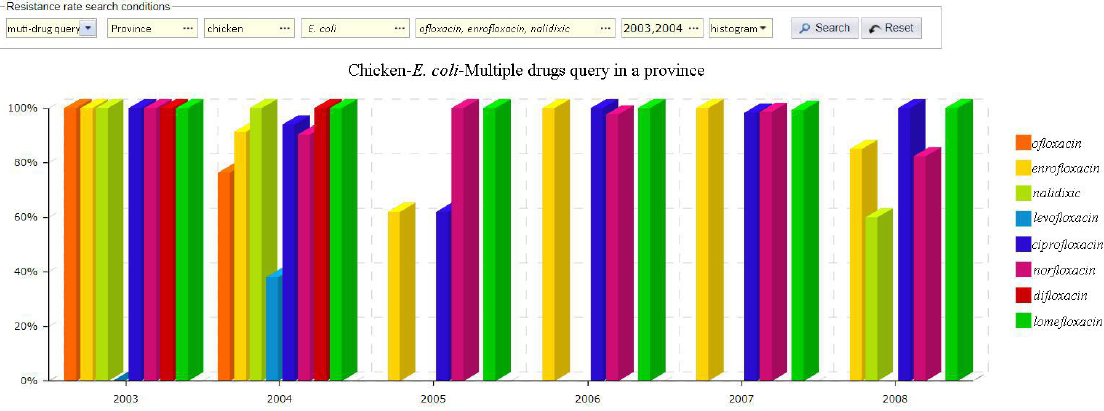
Figure 5. Multiple drugs query ( sample data ) .